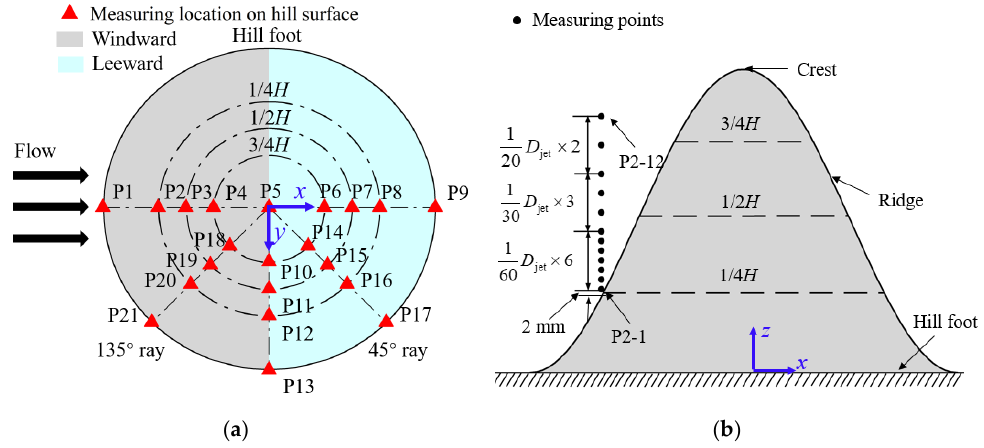
Figure 4. Layout of measuring locations and measuring points: ( a ) measuring location; ( b ) measur-